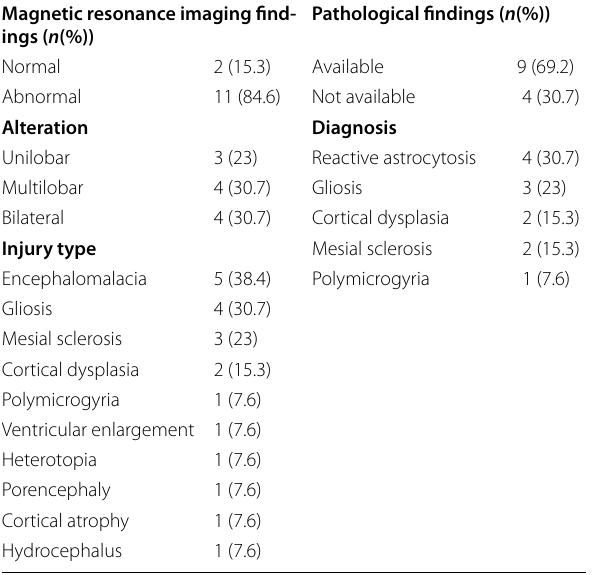
Pathological findings ( n (%))